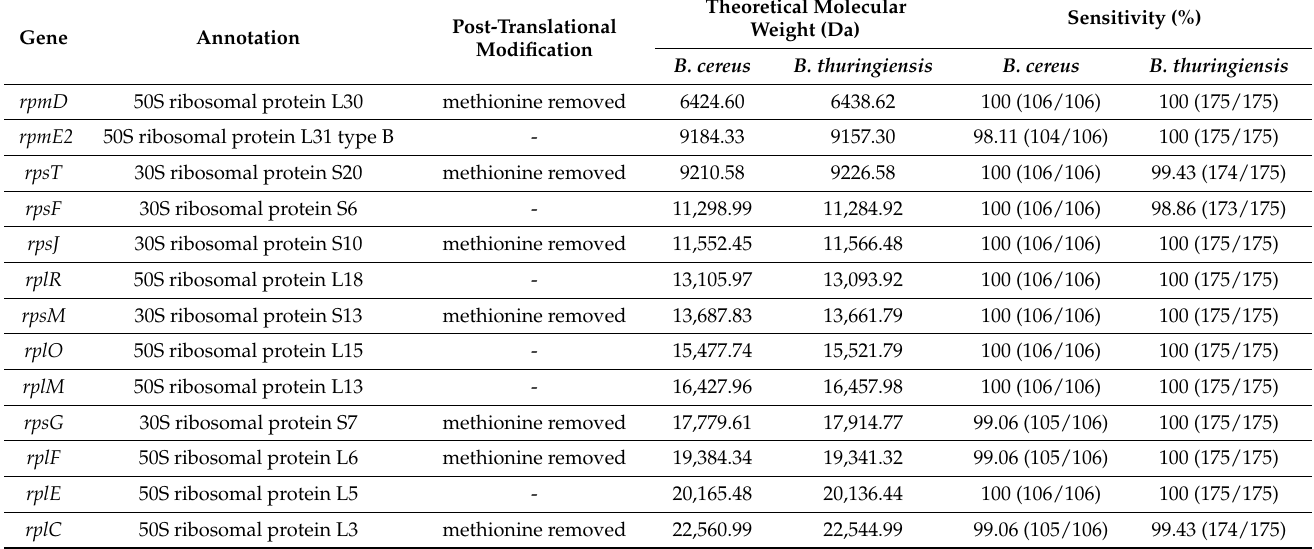
Table 1. Theoretical molecular weight and sensitivity of ribosomal proteins with variations between Bacillus cereus and Bacillus thuringiensis from the genome